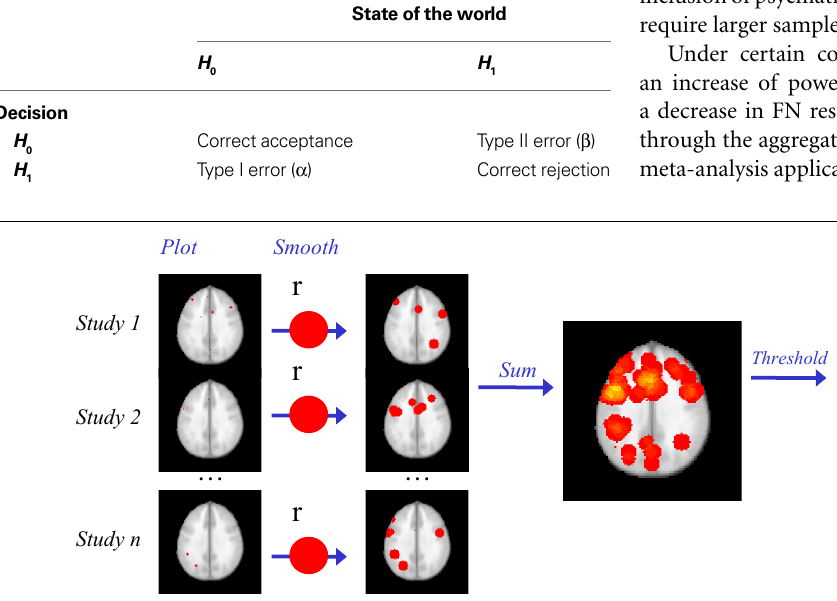
each voxel. Step 4: the p value of the observed proportion is computed, under the null hypothesis that the activations are generated at random spatial locations. The fi nal thresholded map refl ects the areas where the proportion of studies reporting activation is too high to have been generated by such null random process alone. In this example of a meta-analysis of language production in healthy subjects, Broca’s area and anterior cingulate are revealed as areas of signifi cant activation (Costafreda et al., 2009a).